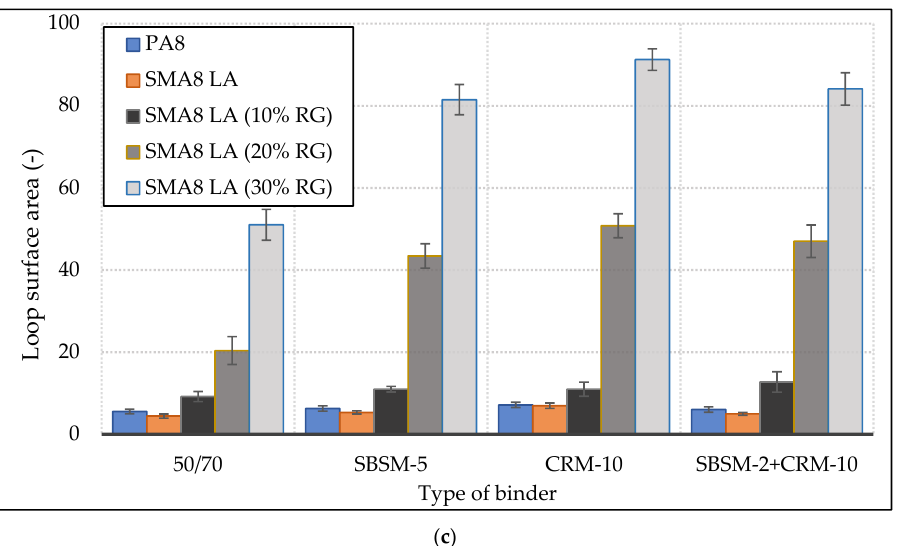
Figure 9. The values of elastic hysteresis loop areas of SMA8 LA and PA8 mixtures at: ( a ) 15°C, ( b ) 25°C, ( c ) 35°C.